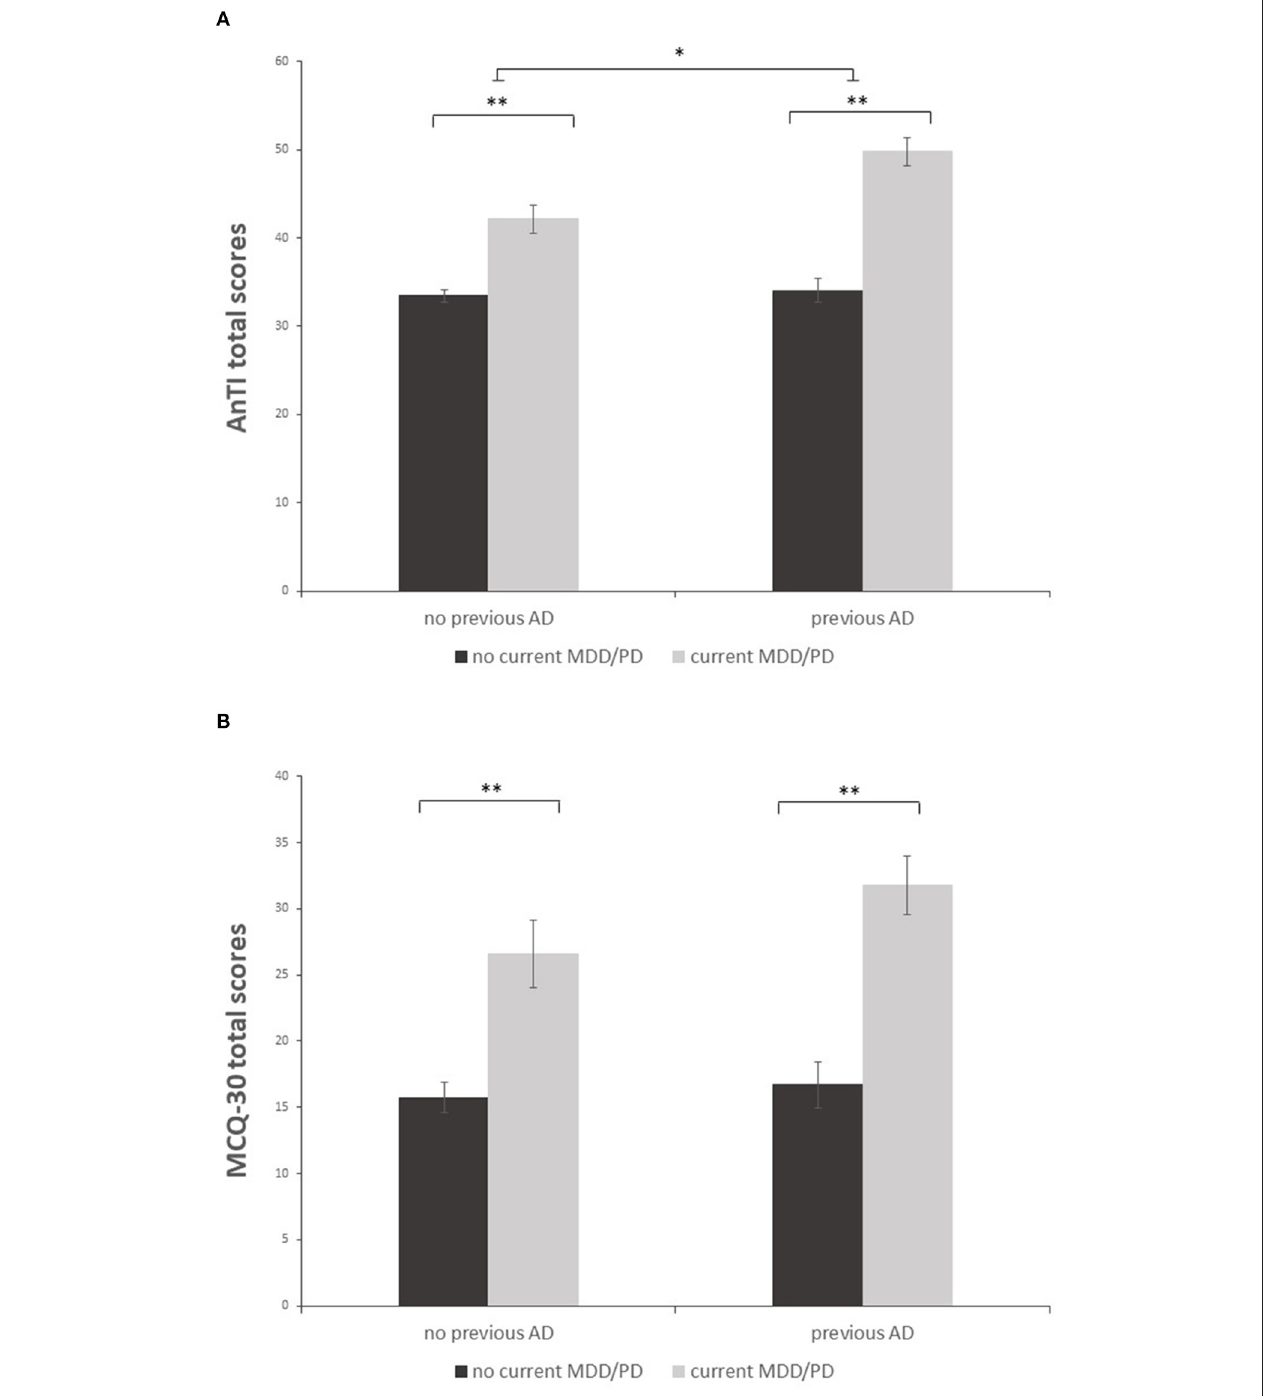
FIGURE 1 | Mean sum scores of the AnTI (A) and MCQ-30 (B) in patients with and without both previous AD and current MDD/PD. Depicted are two significant main effects for the factors current MDD/PD and previous AD (A) and one significant main effect for the factor current MDD/PD (B) . Error bar indicate ± 1 standard error of the mean. ** p < 0.001; * p <